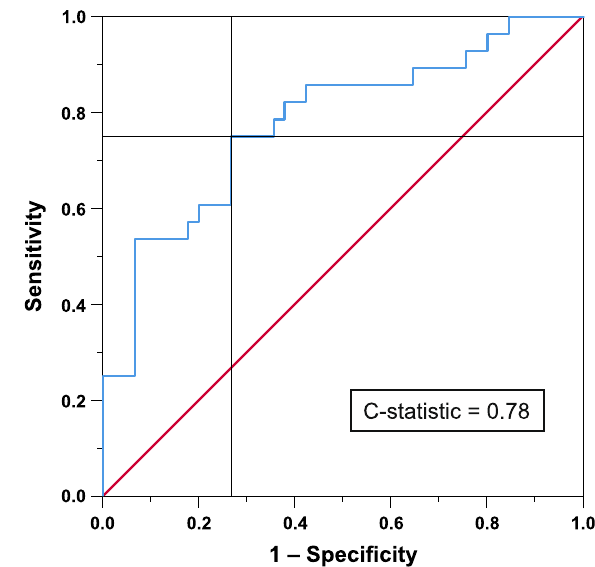
Fig. 2 Receiver operating characteristic curve. The receiver operating characteristic curve (blue) illustrates the classi fi cation accuracy of the fi tted logistic regression model (dependent variable: PDQ-8 SI “ Responder ” / ” Non-Responder ” , independent variables: age baseline , PDQ-8 SI baseline , NMSS-total score baseline, NMSS item 12 baseline , NMSS item 16 baseline ). The discriminatory power of the test with these parameters is demonstrated by C-statistic = 0.78. The diagonal line (red) represents chance classi fi cation accuracy. The cross of black reference lines indicates the optimal trade-off point in which the model reached 75.0% sensitivity and 73.3% speci fi city. NMSS Non-Motor Symptom Scale, PDQ-8 SI 8-item Parkinson ’ s Disease Questionnaire Summary